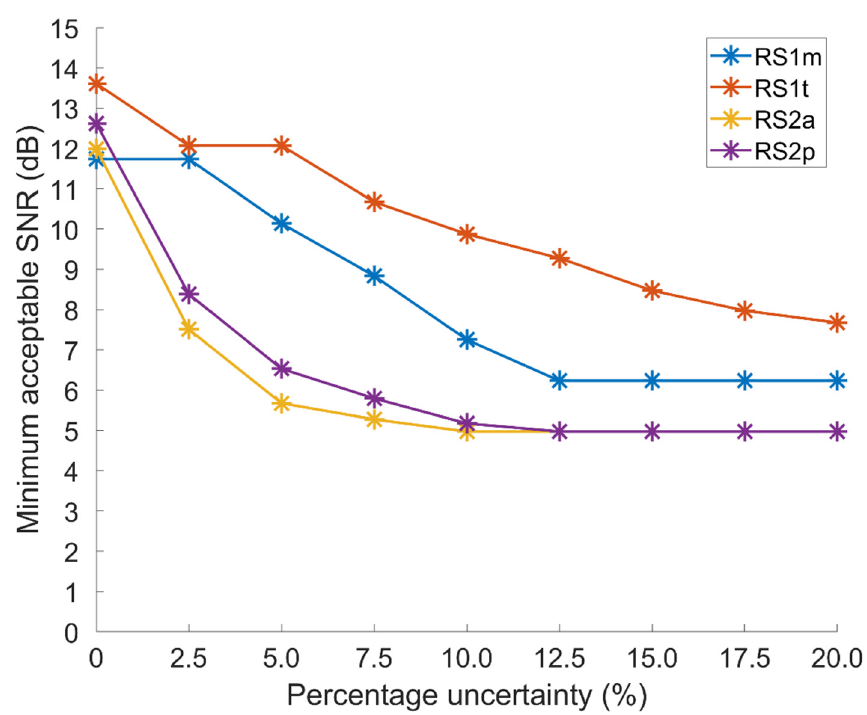
Figure 6. Minimum acceptable SNR for the estimation of respectively R-S 1,M , R-S 1,T , R-S 2,A , and R-S 2,P as a function of the acceptable percentage uncertainty over the measurement of the hearth valves closure latencies.